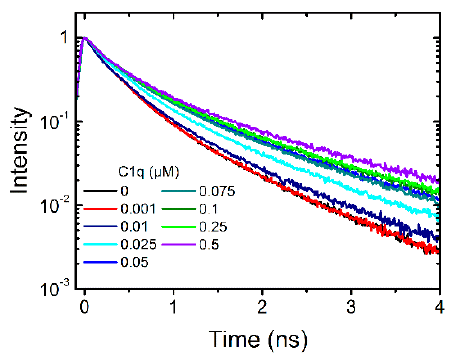
Figure 4. Fluorescence lifetime curves of 0.1 µM dPGS-ICC alone and with eight different concentrations Fluorescence lifetime curves of 0.1 µ M dPGS-ICC alone and with eight different of the complement protein C1q (0.001 µM to 0.5 µM) in DPBS at 20 °C.